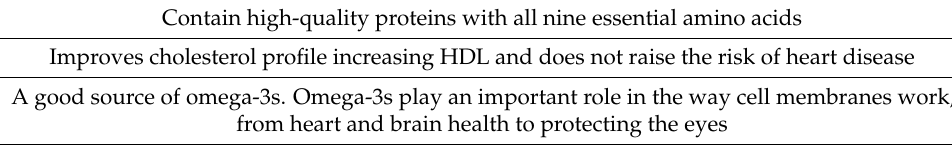
Table 3. Functions and benefits of eggs in a child’s diet (modified from [37]). Contain high-quality proteins with all nine essential amino